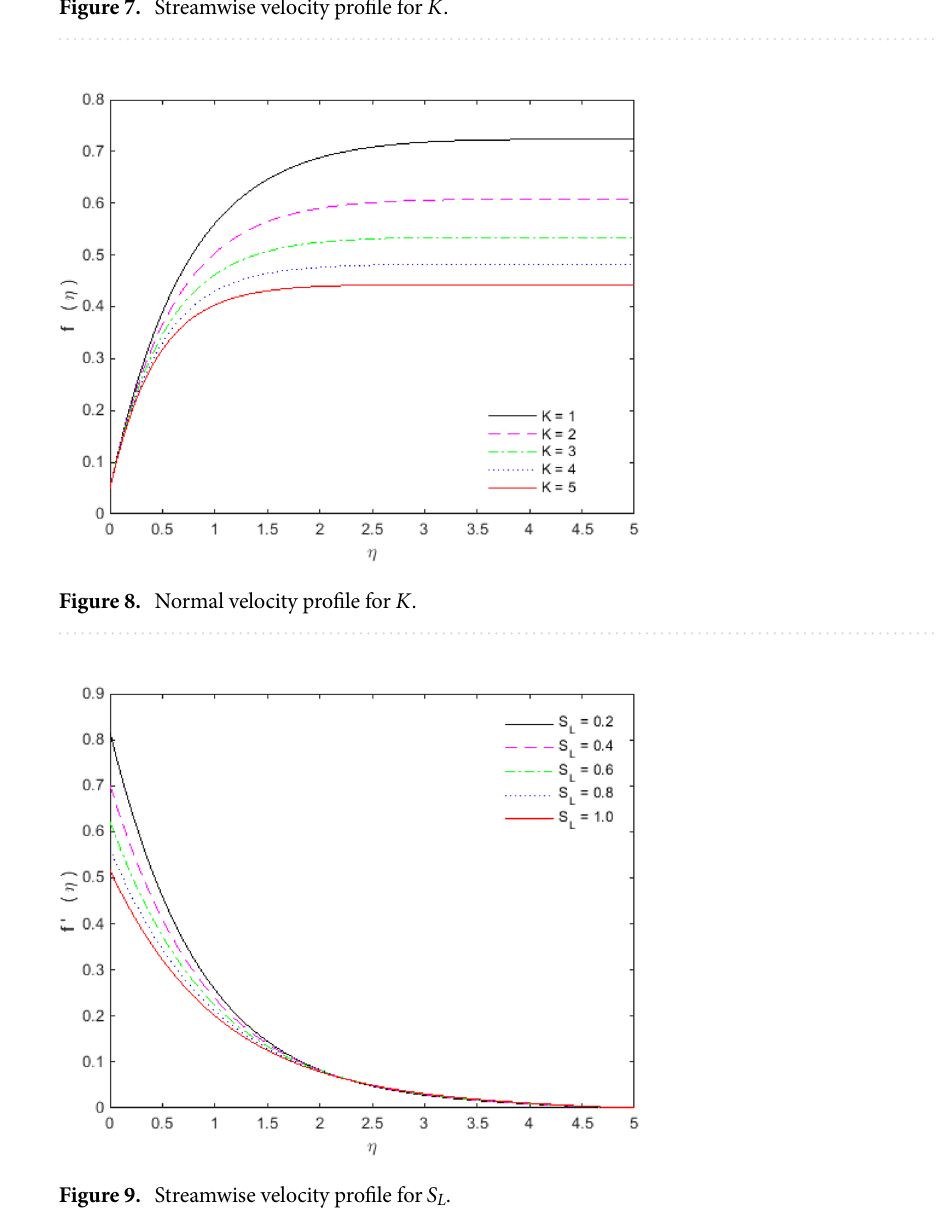
Figure 7. Streamwise velocity profile for K .